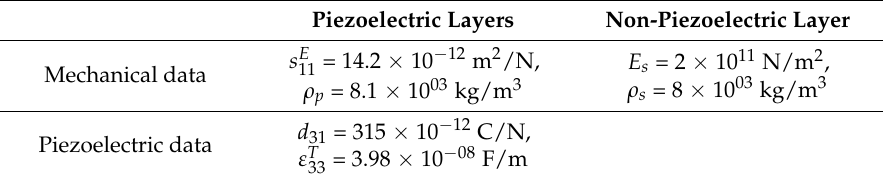
Table 3. Material properties of the bimorph piezoelectric energy harvesters.